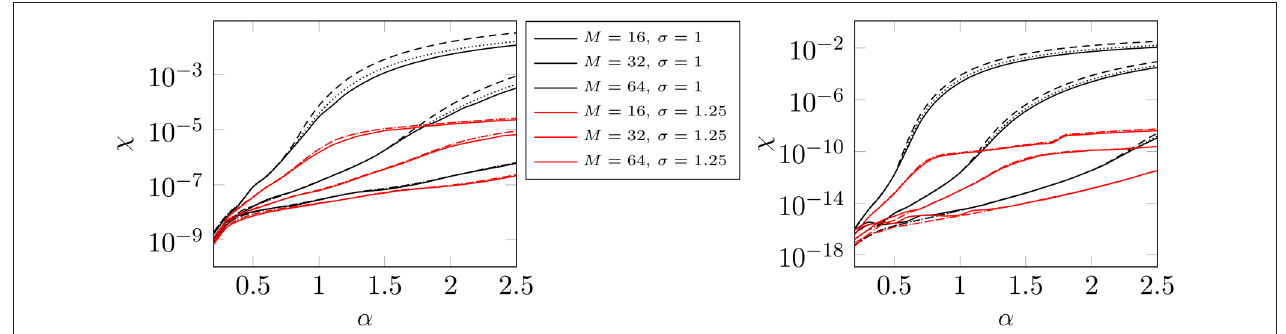
FIGURE 4 | Approximate values for χ opt via Equation (46) (dotted) and χ std via Equation (45) (dashed) for different far field cutoffs M with respect to the splitting parameter α . Thereby we choose the support parameter m corresponding measured errors ( χ std ) are represented by the solid lines. (Window function: Bessel).